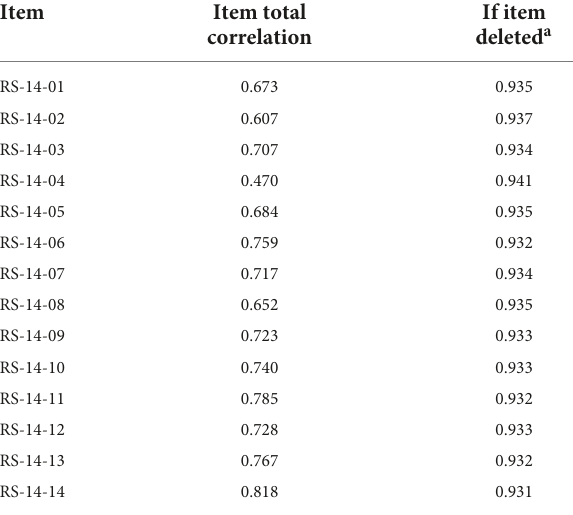
TABLE 3 Internal consistency-Cronbach’s coefficient of the RS-14 ( n =